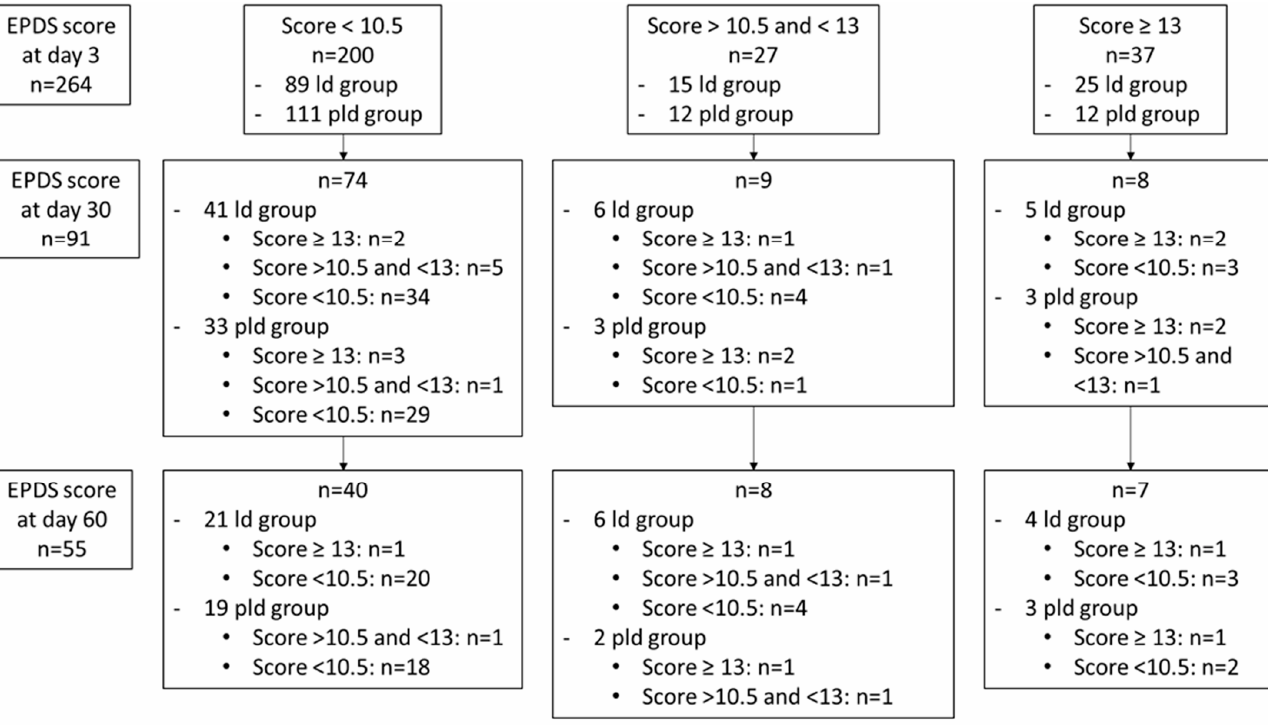
Figure 2. EPDS score by follow-up and questionnaire completion at D30 and/or D60. EPDS = Edin- burgh Postnatal Depression Scale, ld = lockdown, pld = post lockdown. Table 3. Bivariate analysis of secondary endpoints at day